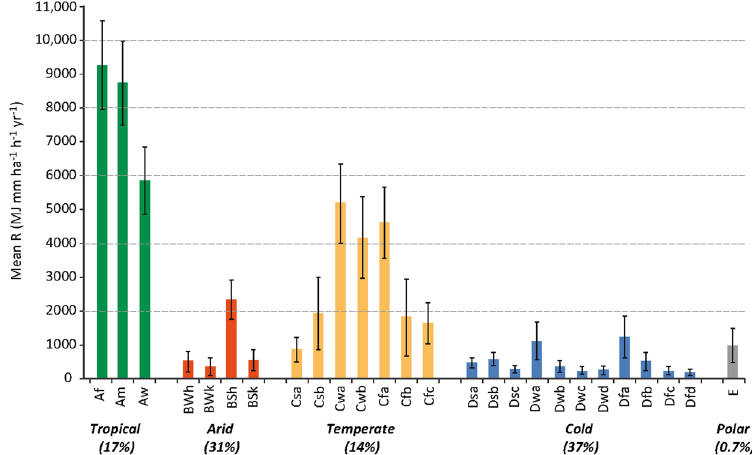
Figure 3. R-factor descriptive statistics per Kopper-Geiger climate type. Colour bars are the mean values per climate zone. Error bars represent the standard deviation. Percentages below each main climate category represent its proportion within the study area. Climate zones: Af (tropical rainforest), Am (tropical monsoon), Aw (tropical savannah), BWh (hot desert), BWk (cold desert), BSh (hot steppe), BSk (cold steppe), Csa (dry hot summer), Csb (dry warm summer), Cwa (subtropical dry winter), Cwb (dry winter and dry summer), Cfa (temperate without dry season and hot summer), Cfb (temperate without dry season and warm summer), Cfc (temperate without dry season and cold summer), DSa (cold and dry hot summer), Dsb (cold and dry warm summer), Dsc (cold and dry cold summer), Dwa (cold and dry winter, and hot summer), Dwb (cold and dry winter, and warm summer), Dwc (cold and dry winter, and cold summer), Dwd (cold and dry winter, and very cold winter), Dfa (cold without dry season and hot summer), Dfb (cold without dry season and warm summer), Dfc (cold without dry season and cold summer), Dfd (cold without dry season and very cold winter), E